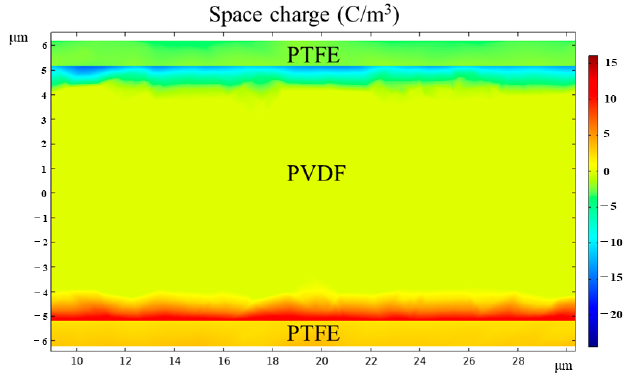
Figure 9. Space charge simulation of PTFE–c–PVDF composite film. Figure 9 . Space charge simulation of PTFE–c–PVDF composite film . Figure 9 . Space charge simulation of PTFE–c–PVDF composite film .